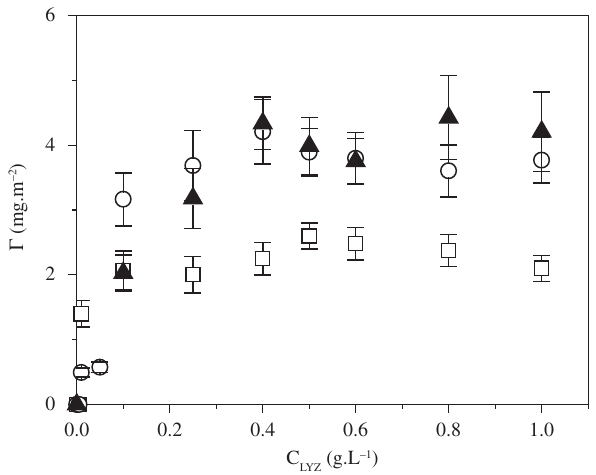
Figure 4. Topographic images of CAP-coated Ti discs obtained by means of a) SEM; and b) AFM, (2 x 2) µm 2 , Z = 10